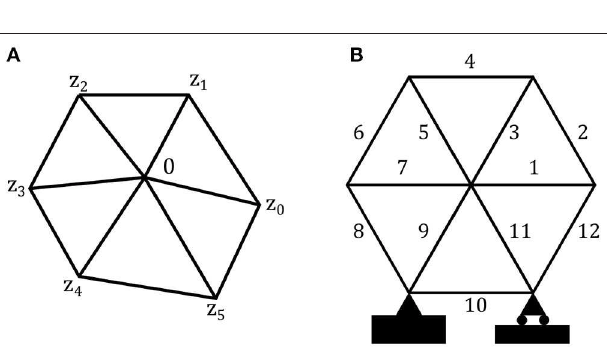
FIGURE 9 | (A) A planar hexagon and (B) a hexagonal system.